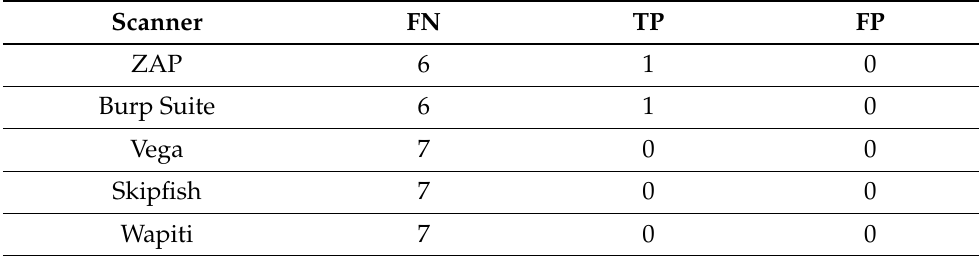
Table 5. FN, TP, and FP results in mode